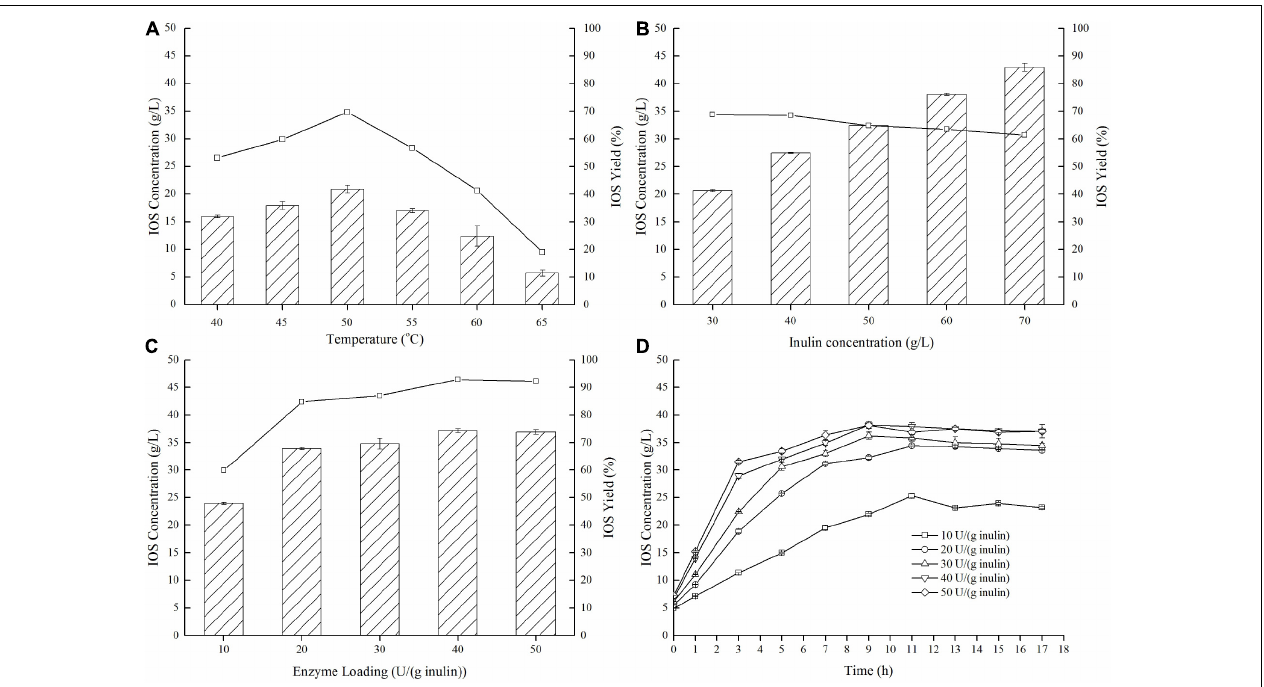
FIGURE 5 | Effects of temperature (A) , inulin concentration (B) , and enzyme loading (C,D) on the production of IOS from inulin by the isolated endo-inulinase. (A) Effect of temperature on IOS production. The conditions of 15 h enzymatic hydrolysis were as follow: 30 g/L inulin, 10 U endo-inulinase per gram of inulin and pH 4.6. (B) Effect of inulin concentration of IOS production. The conditions of 15 h enzymatic hydrolysis were as follow: 10 U endo-inulinase per gram of inulin, pH 4.6 and 50 ◦ C. (C) Effect of enzyme loading on IOS production. The conditions of 15 h enzymatic hydrolysis were as follow: 40 g/L inulin, pH 4.6 and 50 ◦ C. (D) Time course of IOS production by different enzyme loading of endo-inulinase. The hydrolytic conditions were as follow: 40 g/L inulin, pH 4.6 and 50 ◦